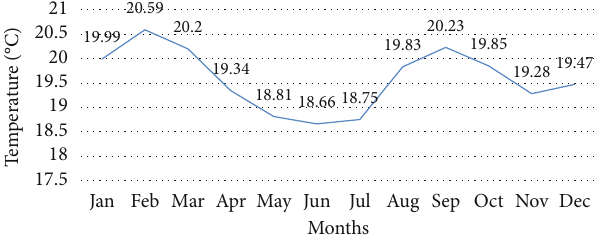
Figure 9: Monthly temperature variation ( ° C) for